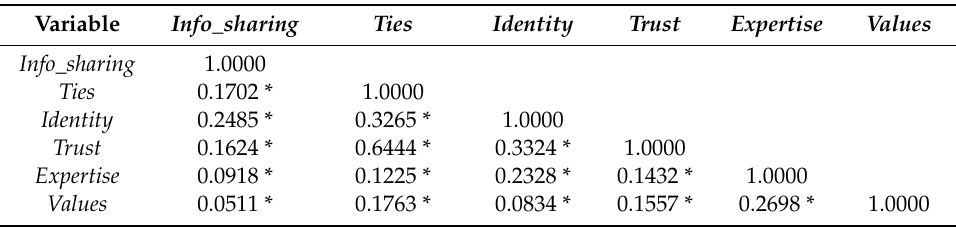
Table 3. Correlation of the